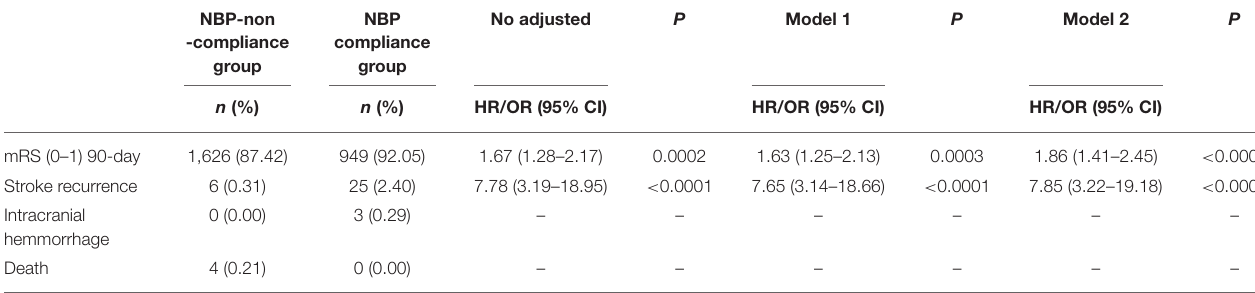
TABLE 2 | Outcome in the bridge trial according to compliance of nbp treatment.